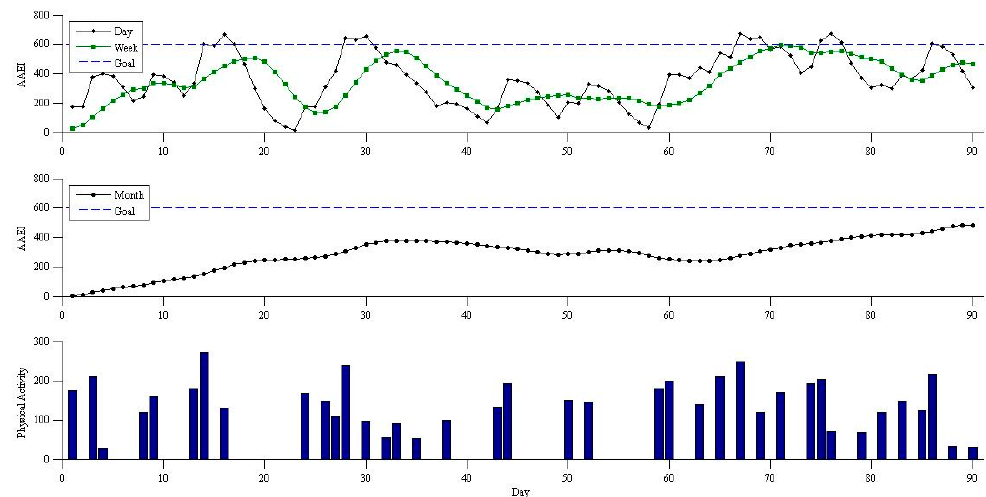
Figure 9. Physical activity and corresponding AAEI without prompting. Simulation model parameters- Intensity: 5 MET; Duration: 30 min; Frequency: 3.